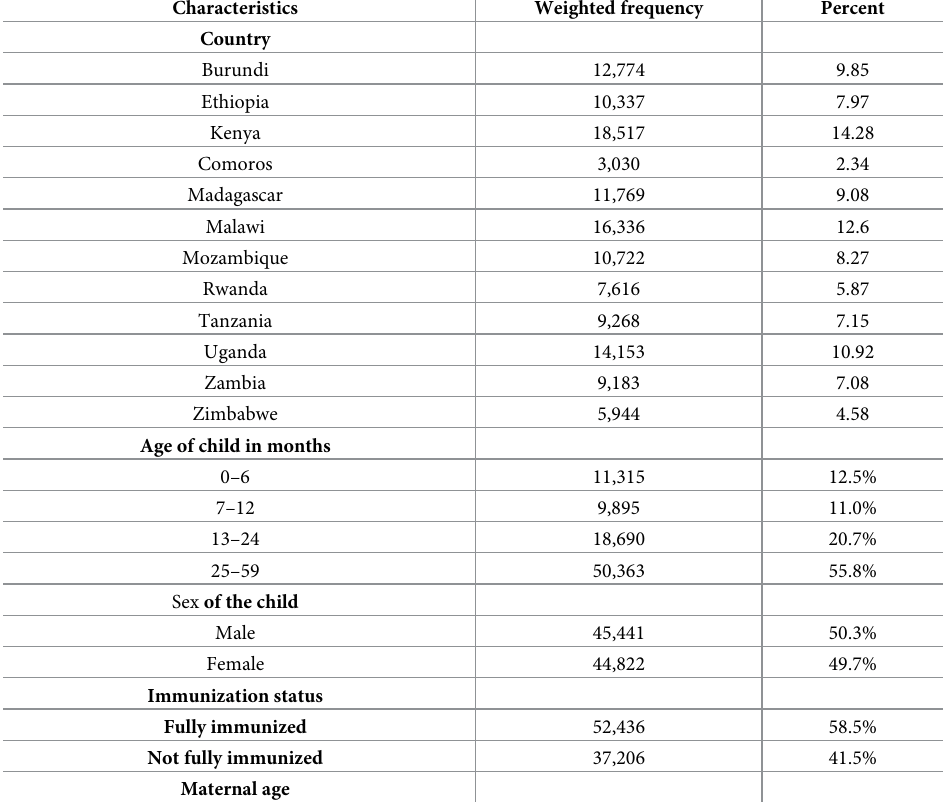
Table 2. Characteristics of the study population in East Africa (N =